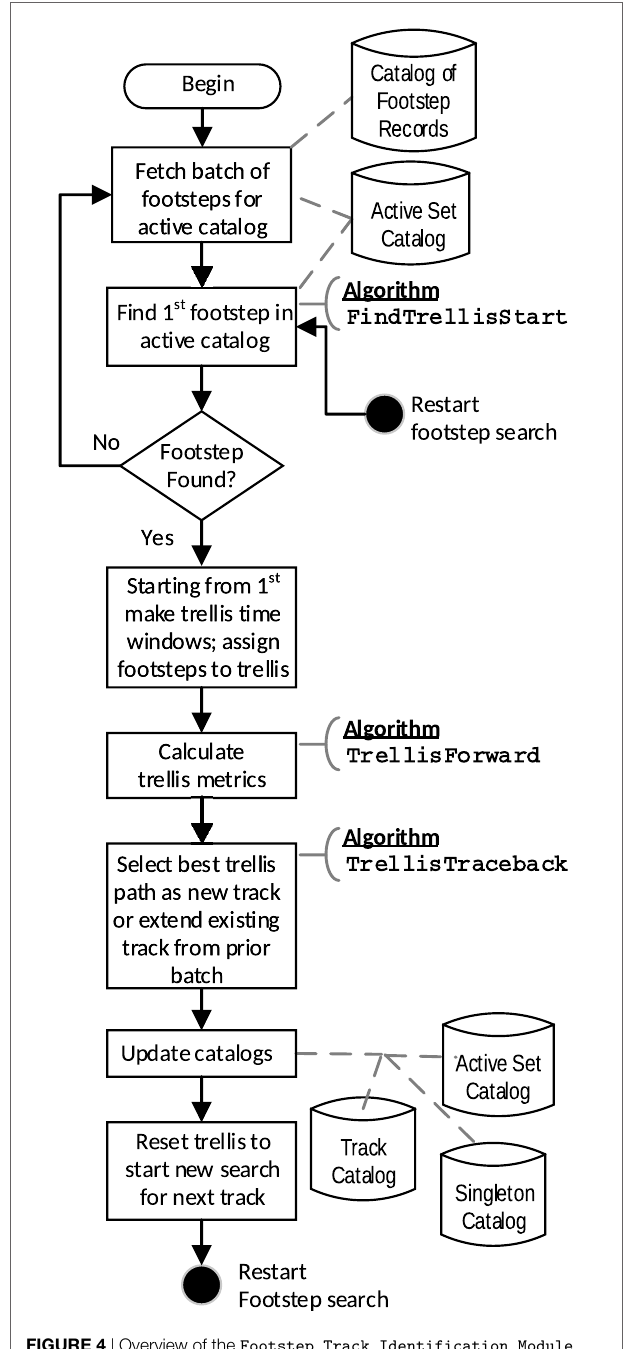
FIGURE 4 | Overview of the Footstep Track Identification Module processing. The processing stages annotated to the right with named algorithms have detailed pseudocode listed in Algorithms 1 – 3